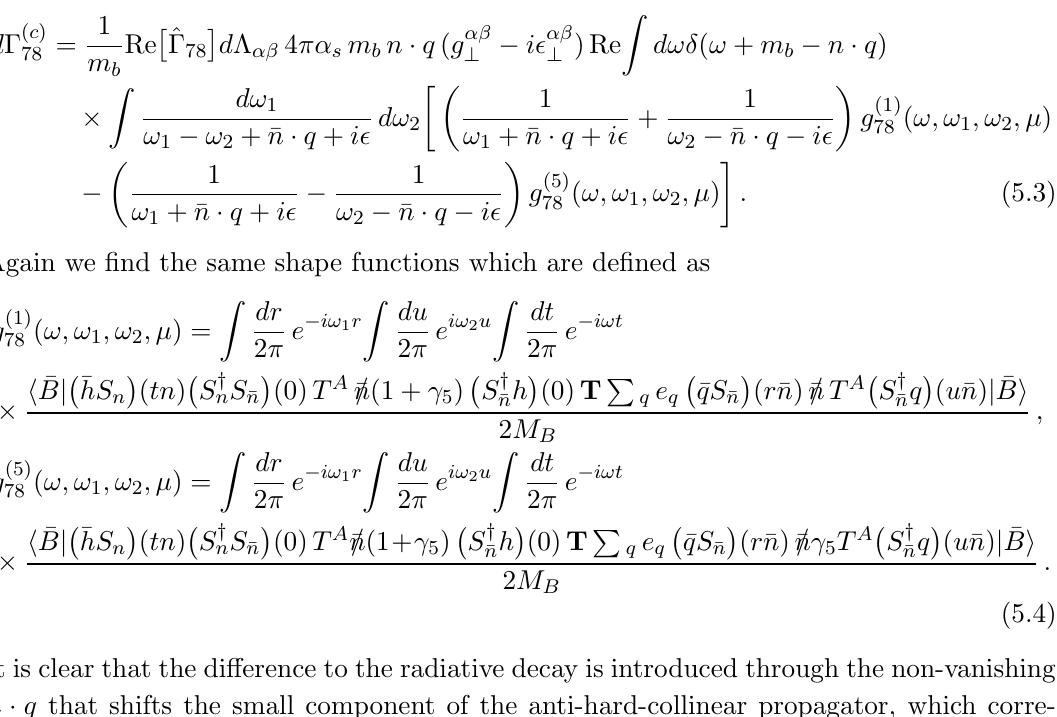
Figure 6 . Diagrams arising from the matching of the two Red indicates soft (cid:12)elds. Integrating out (anti-) hard-collinear (cid:12)elds leads to non-localities which are denoted by dashed